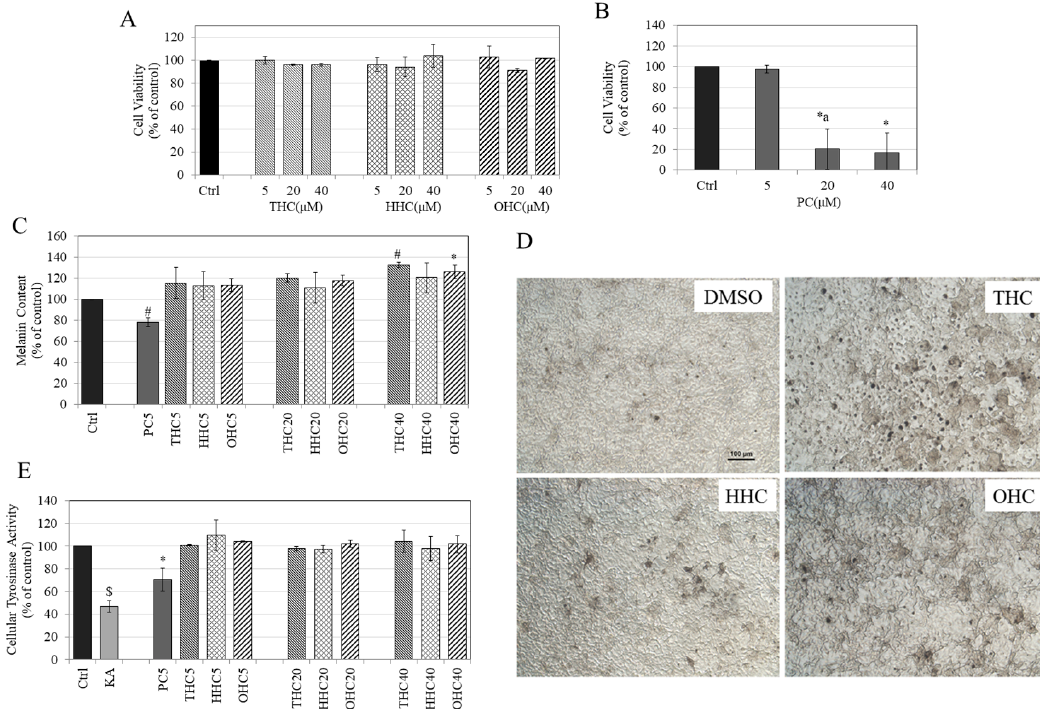
Figure 2. Viability of B16F10 mouse melanoma cells treated with ( A ) THC, HHC, OHC and; ( B ) PC for 3 d over a concentration range (5–40 µ M) measured using Alamar Blue assay; (One-way ANOVA followed by Tukey’s test; * p < 0.05 vs. Ctrl; letter a— p < 0.05 vs. PC5; Data are mean ± SD of at least two independent experiments); ( C ) Melanin content in B16F10 cells treated with PC and HMs for 3 d; (* p < 0.05 and # p < 0.001 vs. Ctrl; One-way ANOVA with Tukey’s test; the numbers with compounds in legends refer to concentrations in µM; Data are pooled from at least two independent experiments); ( D ) Representative images of B16F10 cells treated with vehicle (0.4% DMSO) or with HMs (THC, HHC, OHC) at 40 µM; scale bar is 100 µm; ( E ) Tyrosinase activity in B16F10 cells treated with PC and HMs for 3 d with kojic acid (KA) (500 µM) used as a positive control; (* p < 0.05 vs. Ctrl; $ p < 0.001 vs. Ctrl; One-way ANOVA with Tukey’s test; Data are means ± SD of at least two independent experiments).